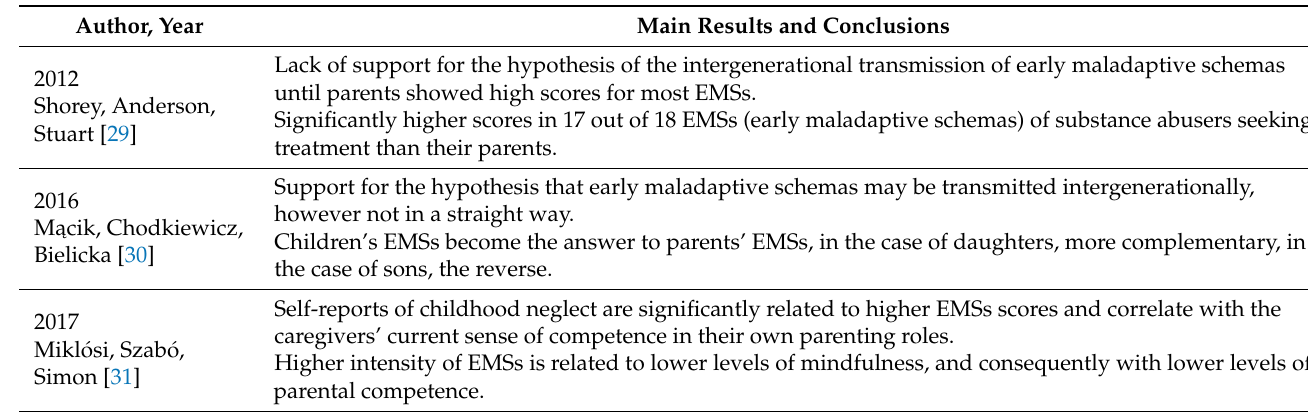
Table 3. Main Results of the Studies